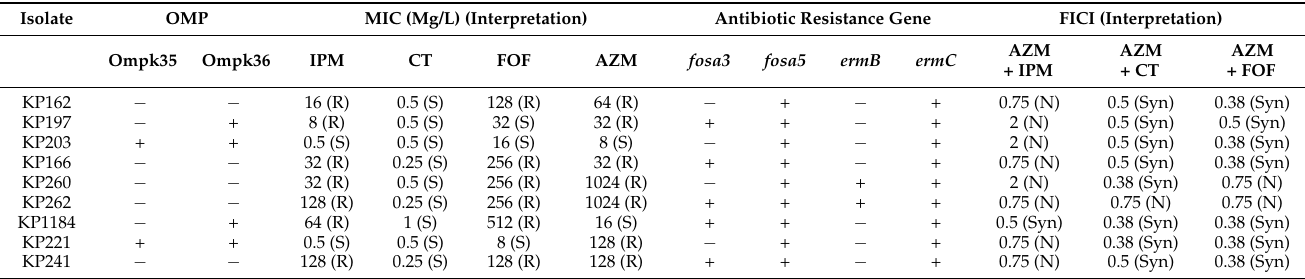
Table 3. The synergistic activity of azithromycin in combination with other antibiotics against OXA-48-producing K. pneumoniae